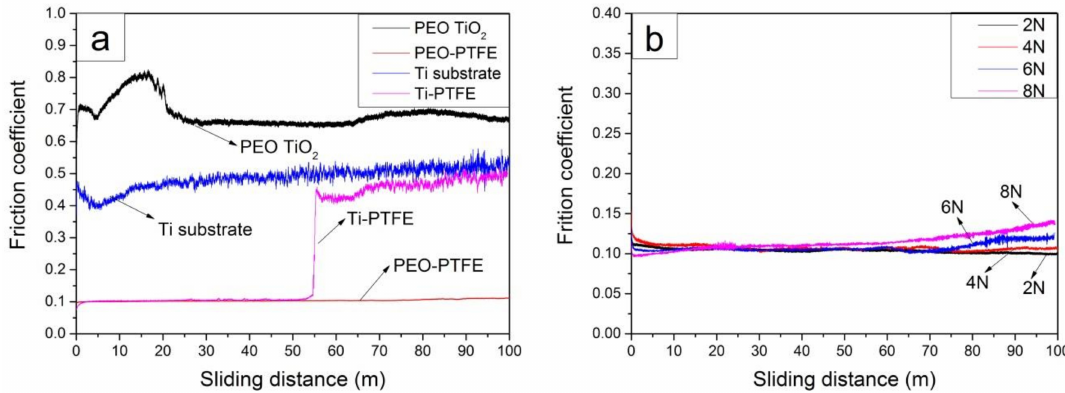
Figure 6. Friction coefficient of different samples against GCr15 after a sliding distance of 100 m ( a ) titanium substrate, Ti-PTFE coating, PEO TiO 2 coating and PEO–PTFE composite coating under the load of 4 N; ( b ) PEO–PTFE composite coating under different